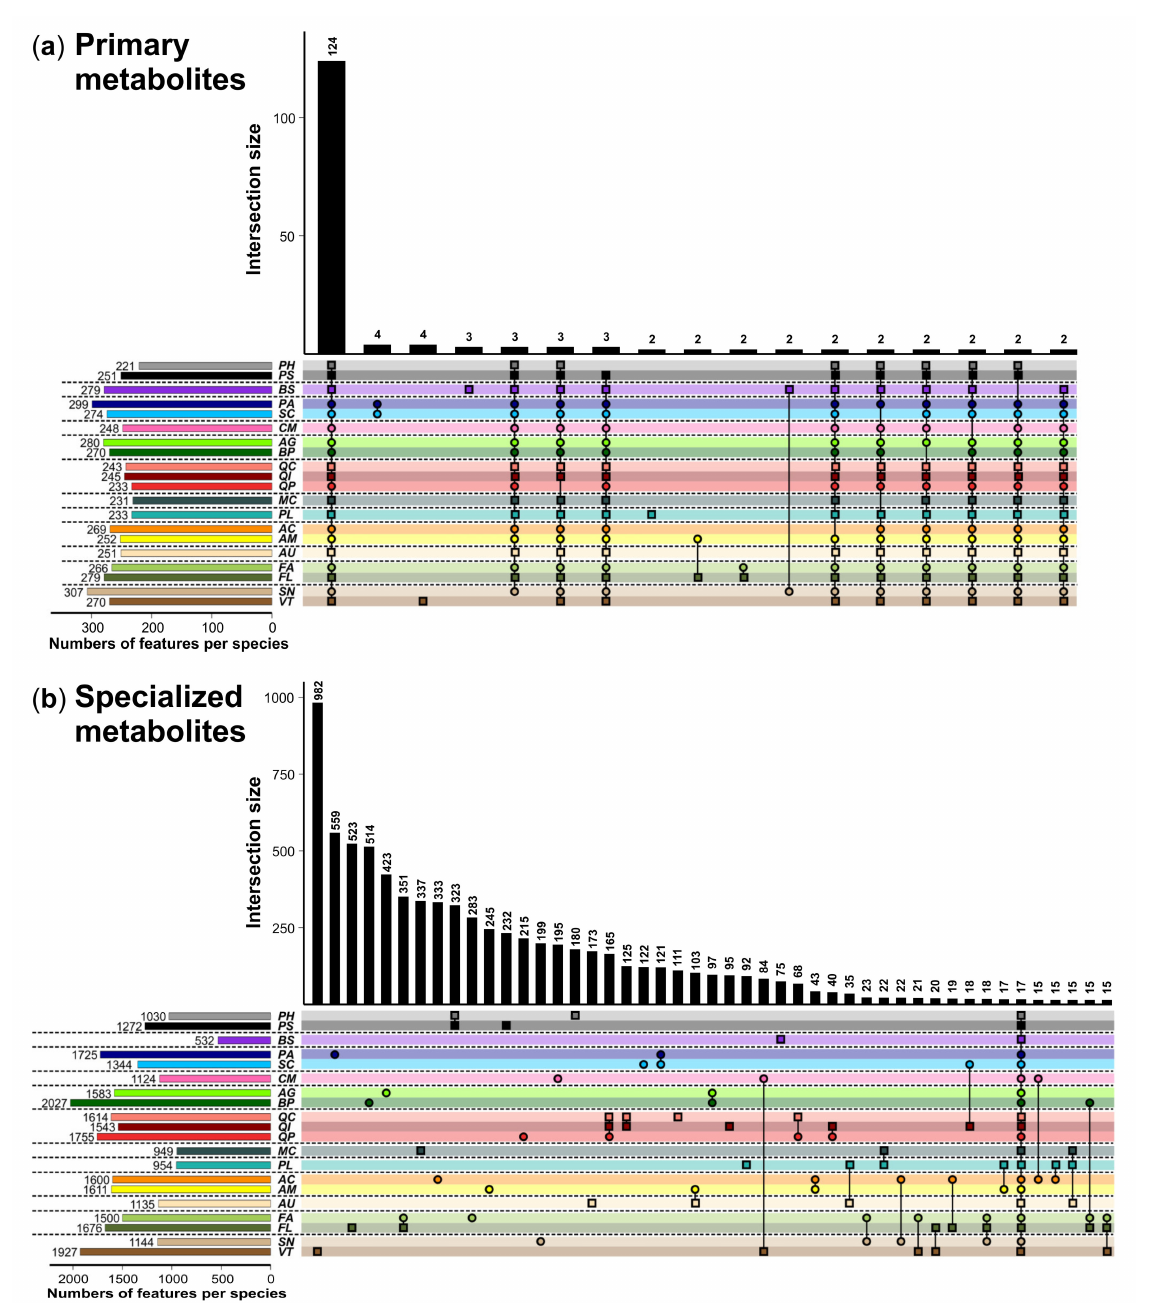
Figure 2. Total numbers ( left ) and occurrence of metabolic features of the ( a ) primary and ( b ) specialized metabolism detected in leaves of 20 plant species shown as UpSet plots ( right ). The vertical bar graphs show the number of features occurring in the (set of) species indicated with symbols below, with intersection sizes of at least two (primary metabolites) or 15 (specialized metabolites). Deciduous species are depicted as circles and evergreen species as squares. The horizontal dashed lines separate the species by plant families. For species abbreviations and taxon assignments, see Table